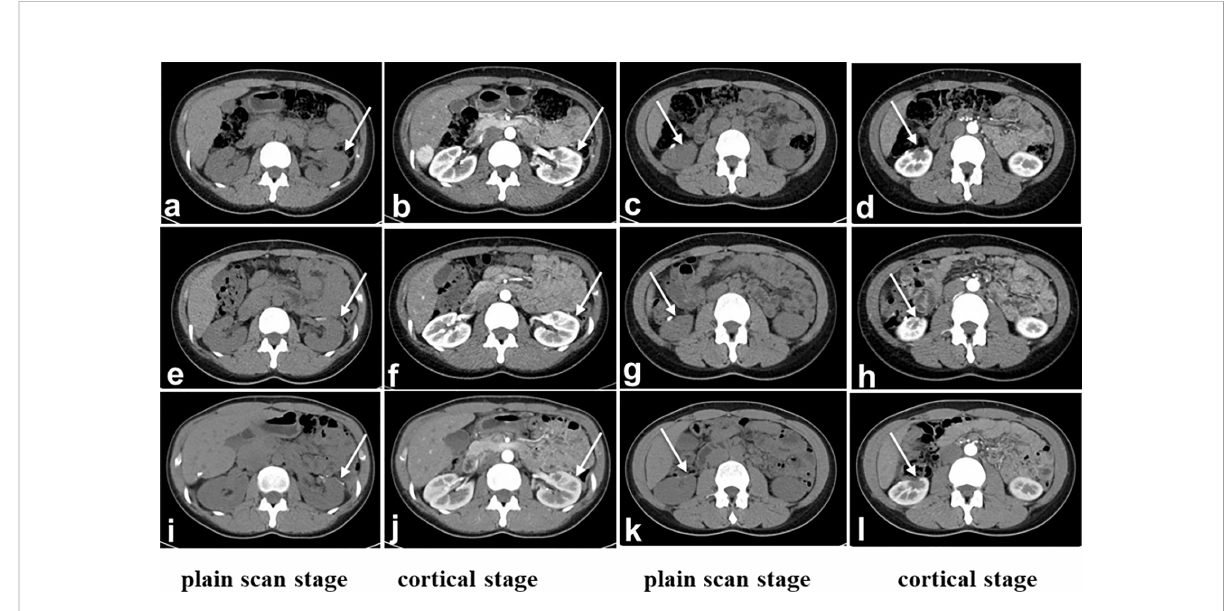
FIGURE 4 CT after surgery. (A-D) : Third month after surgery, (E-H) : 6 months after surgery, (I-L) : 24th month after surgery. The margins of the upper left kidney (A, B, E, F, I, J) and lower right kidney (C, D, G, H, K, L) were irregular. The perirenal space of the bilateral kidneys was clear, and the shape and size were normal. There was no obvious enlarged lymph node shadow in the retroperitoneum. (A, E, I) : Plain scan stage. (B, F, J) : Cortical stage. (C, G, K) : parenchymal stage. (D, H, L) : Renal pelvis stage. The white arrow indicates status of partial nephrectomy.